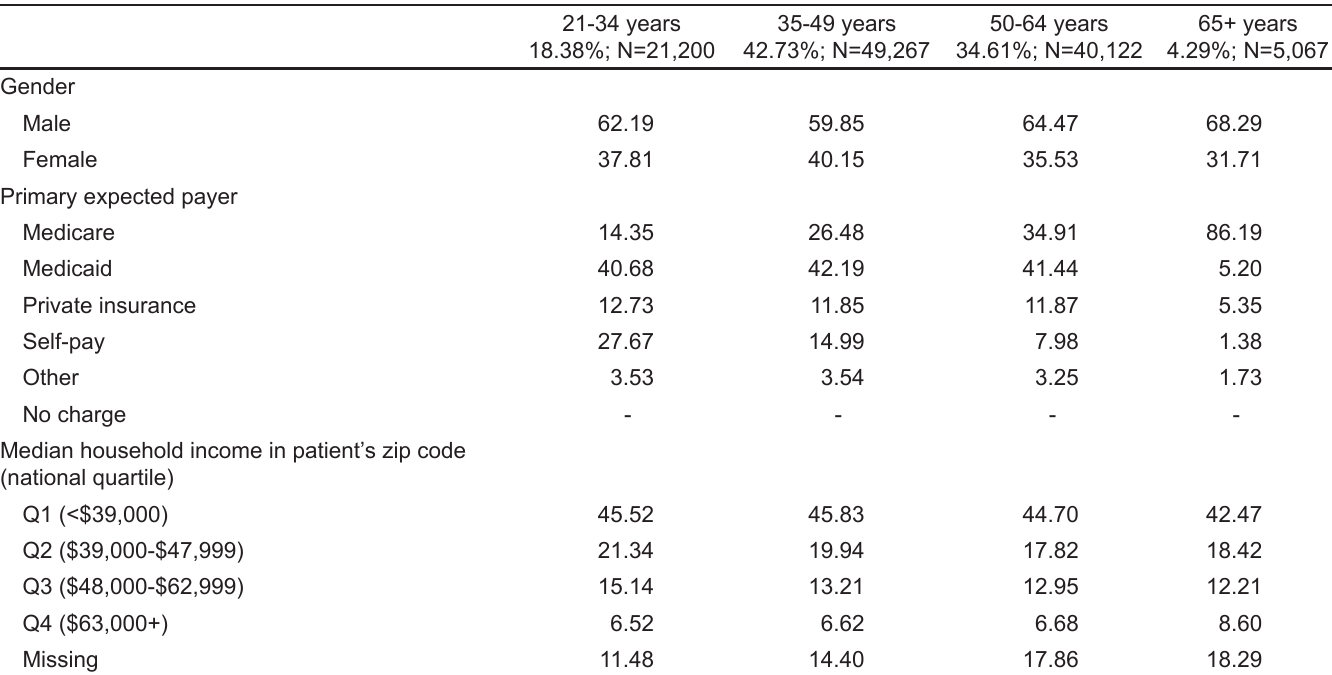
Table 3. Visits by patients with human immunodeficiency virus diagnosis: characteristics by age group